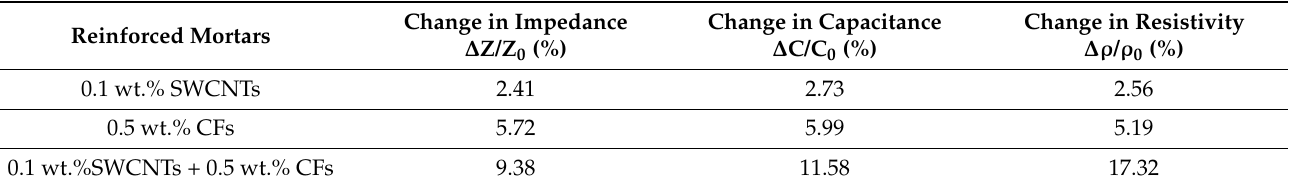
Table 3. Changes in impedance, capacitance, and resistivity values (%) of 28 d plain and hybrid- modified